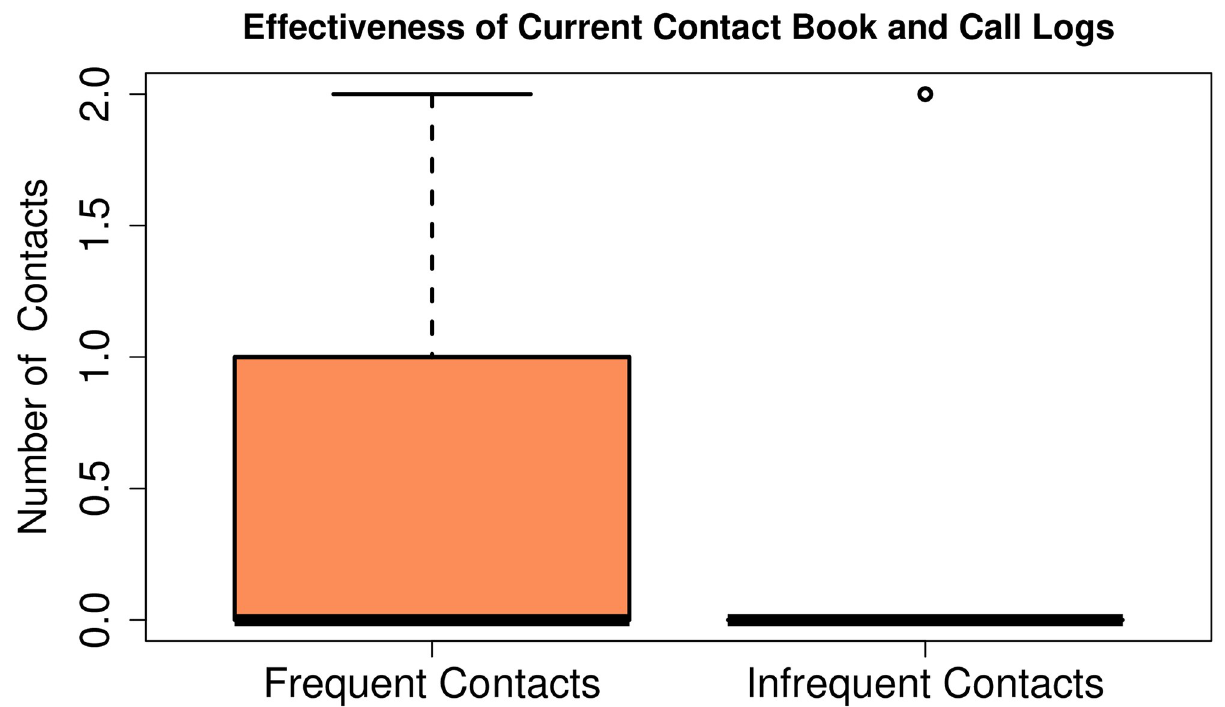
Fig 2. Effectiveness of the current contact-book and call log interfaces. This figure shows the number of correctly identified frequent and infrequent contacts through the traditional call logs and contact-book interfaces by illiterate users. It can be clearly seen that most users were unable to correctly identify both of their frequent contacts and none of them could find the infrequent numbers except one participant. This indicated the serious usability problem in the current smartphone interfaces for illiterate users.